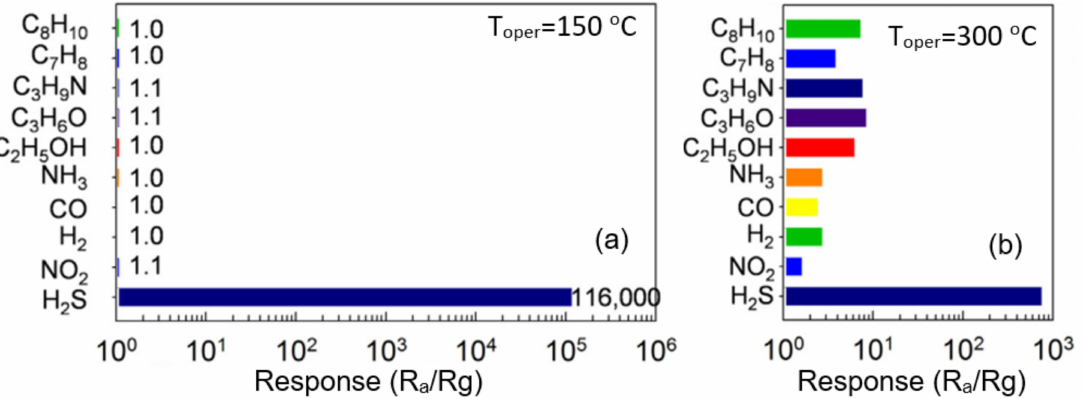
Figure 27. Gas responses of CuO-loaded In 2 O 3 nanofiber sensors toward various gases at ( a ) 150 ◦ C and ( b ) 300 ◦ C. The response corresponds to R a /R g ratio for reducing gases and to R g /R a for NO 2 . Reprinted with permission from [297]. Copyright 2015